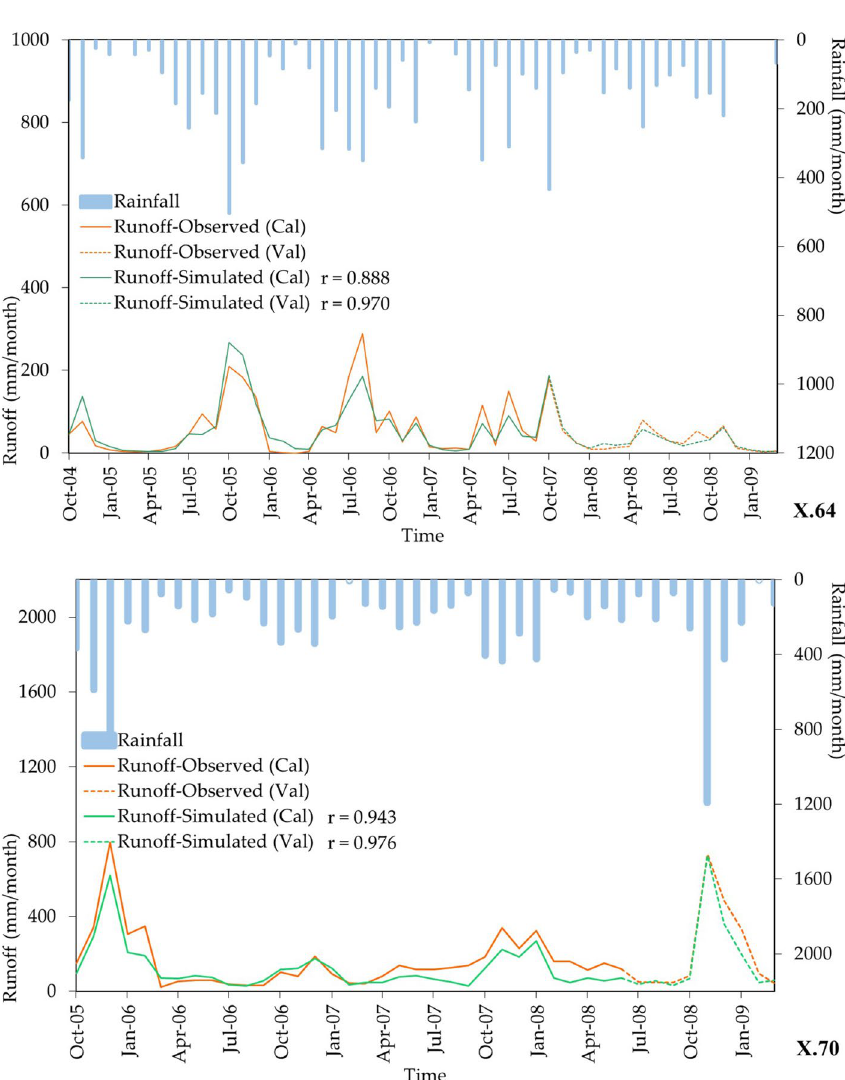
Figure 6. The rainfall and runoff time series at runoff stations X.64 and